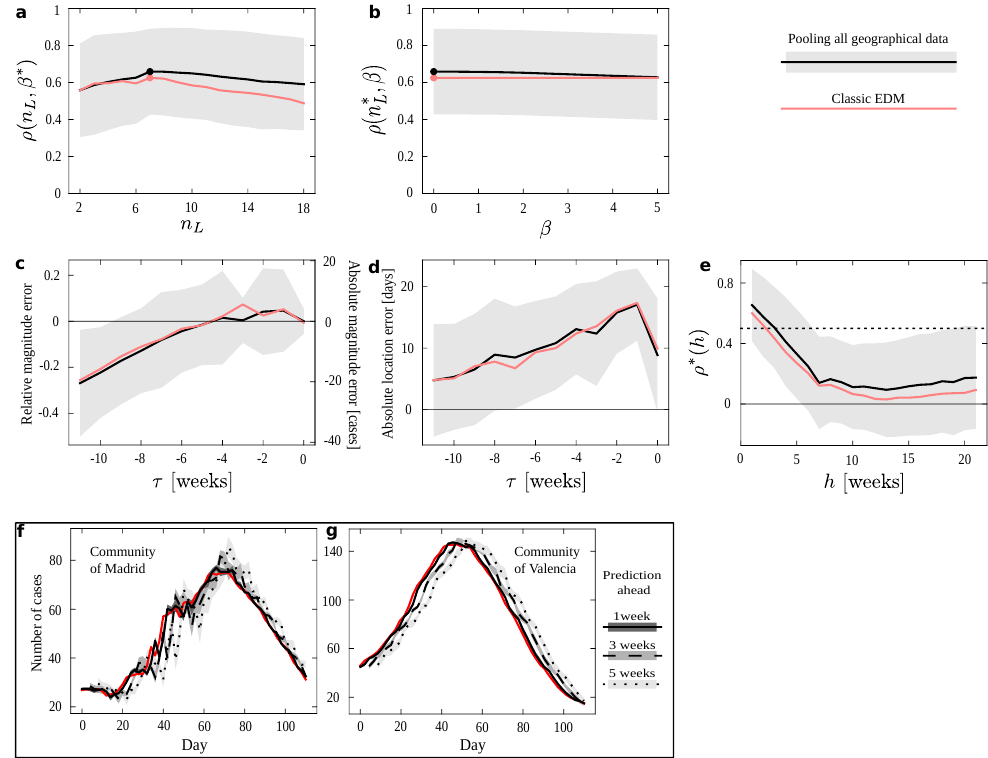
Figure 4. Pooling geographically distributed information for COVID-19 forecast. ( a – e ) Results of different numerical experiments for conditions pool (solid black curves, with shading indicating standard deviation), classic (solid red) and annual (dashed red). Filled circles in ( a – b ) mark the location of optimal meta-parameters for each protocol. The optima for pool are also marked by vertical solid lines. Solid horizontal lines in ( c – f ) mark the 0 of the vertical axis. Solid vertical lines in ( c – e ) mark the location of the peak in time. Dotted horizontal line in ( f ) marks ρ ∗ ( h ) = 0.5. ( a ) EDM performance (as measured by correlation between data and forecast) as a function of n L with fixed, optimal β ∗ . ( b ) EDM performance as a function of β with fixed, optimal n L . ( c ) Average error in forecasting the peak magnitude. d Average error in forecasting the peak location. ( e ) EDM performance as we attempt to predict more time ahead. ( f , g ) Examples of how forecast become worst as we attempt to predict with more anticipation. Real data (solid red curves) is compared to forecasts derived with one week (solid black), three weeks (dashed black), or five weeks (dotted black) of anticipation. The various shadings indicate standard deviation of the estimated quantity. ( f ) Forecasts for the Community of Madrid. ( g ) Forecasts for the Community of